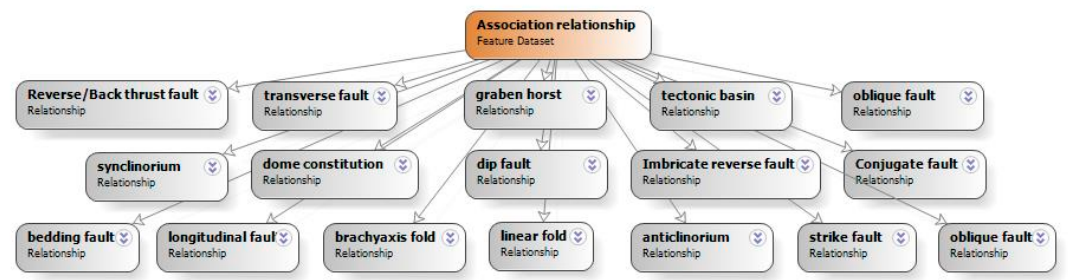
Figure 6. Logical model map of the feature dataset for the combined relationships.